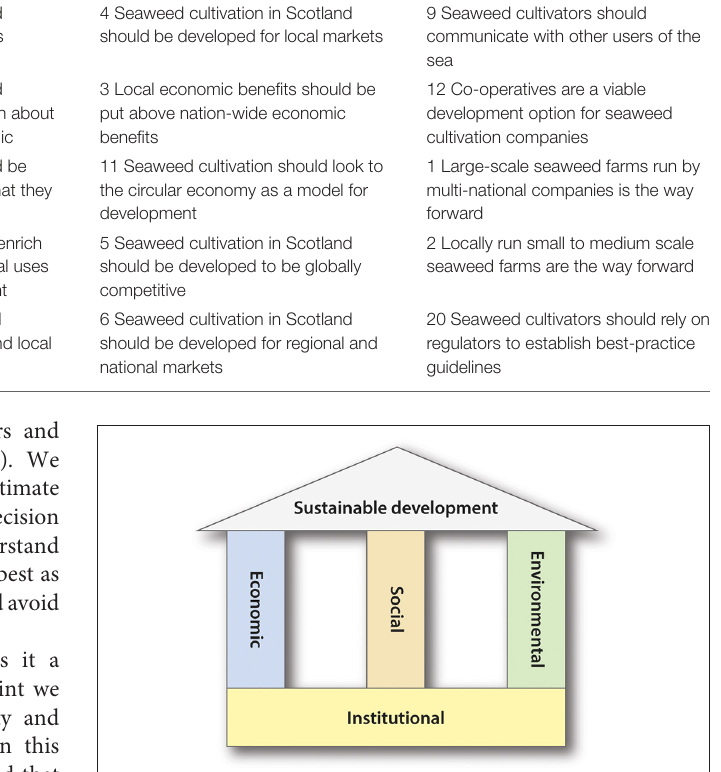
TABLE 2 | Statements/opinions (concourse) on seaweed cultivation in Scotland chosen by the authors from the Q-sample. Environmental sustainability